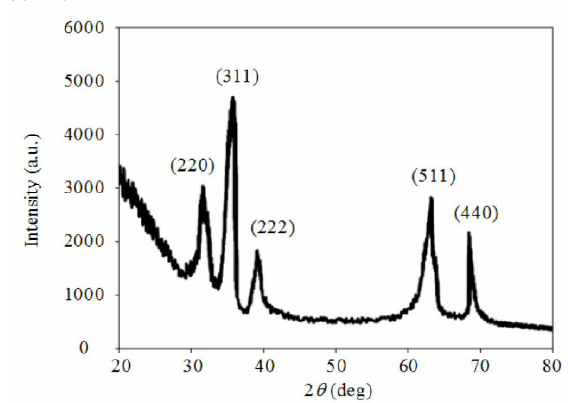
Fig. 2 XRD pattern of the prepared sample of 100-nm thickness.